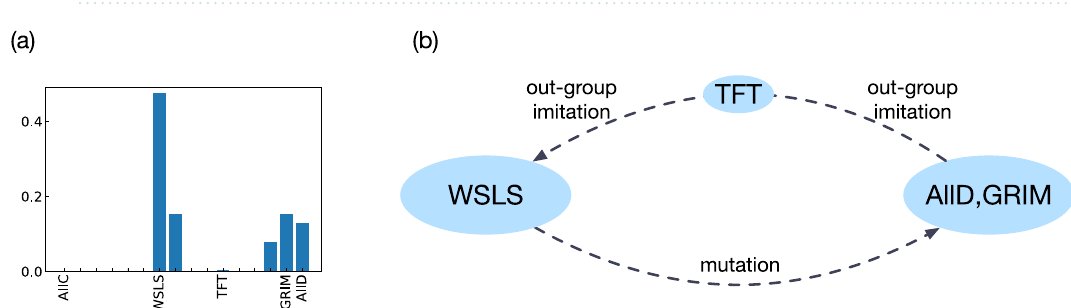
Figure 5. Comparison of well-mixed and group-structured populations when there is a partial separation of time scales. ( a ) We consider a well-mixed population ( N = 200 , M = 1 ) and a group-structured population ( N = 2 , M = 100 ), assuming that the relative probability of mutations is r = 0.01 . In both cases we simulate the evolutionary process with Monte Carlo simulations and record how often players cooperate on average. For well-mixed populations, these average cooperation levels strongly depend on the benefit of cooperation. In contrast, for group-structured populations, average cooperation levels are approximately 1/2, independent of the considered cooperation benefit. In particular, we recover our previous result that group-structured populations yield more cooperation when b is small, and less cooperation when b is large, compared to the corresponding well-mixed populations. ( b ) The results are qualitatively robust across many values of r (relative mutation probability). The points in this graph depict the result of Monte Carlo simulations. Dashed lines are the predictions by Eq. (26).